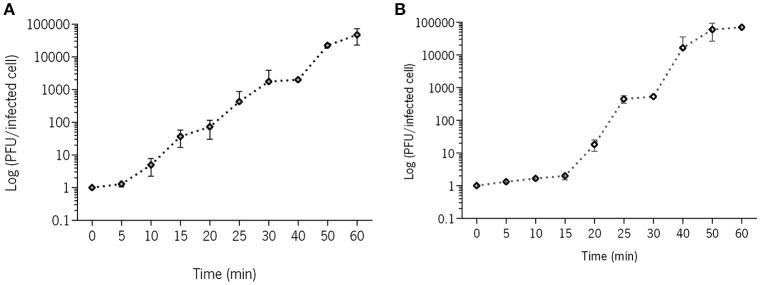
One-step growth curve of phages (A) PAO1-D and (B) EC3a in their respective hosts. Error bars represent standard deviations from 2 independent experiments performed in duplicate.